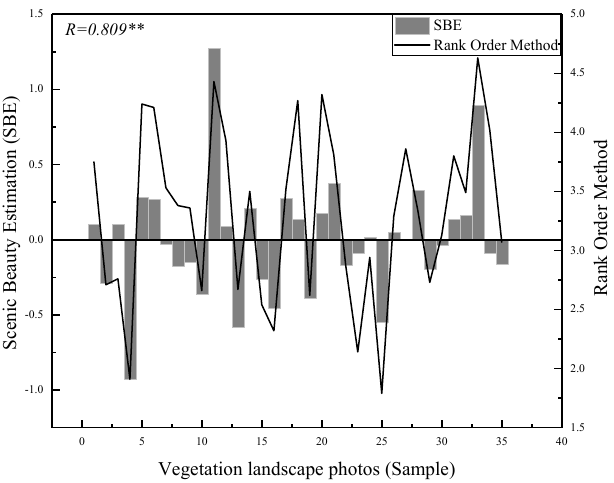
Figure 2. SBE and comprehensive ranking scores of vegetation photos. Note: The asterisk ** (0.01 level; two-tailed) represents significant correlations.